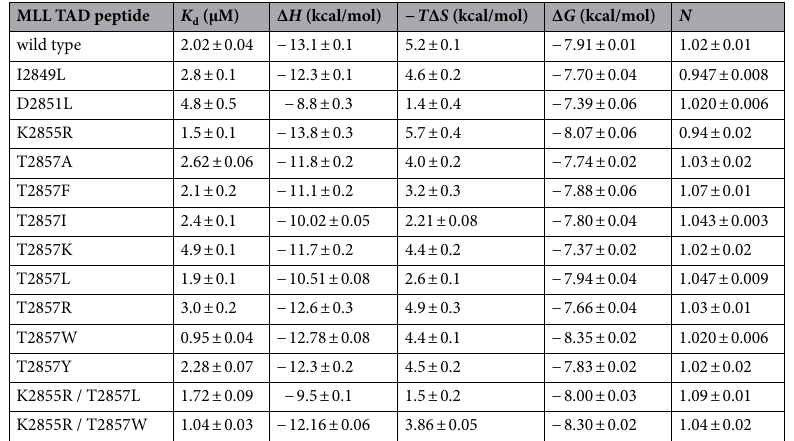
Table 1. Thermodynamic parameters for KIX binding of the designed peptides. The dissociation constant ( K d ), changes in enthalpy (Δ H ), entropy (Δ S ), and Gibbs free energy (Δ G ) upon binding, and stoichiometry of binding ( N ) were measured using isothermal titration calorimetry. The mean and standard error of triplicate or more measurements are shown. The K d values are plotted in Fig. 4d, and other parameters are plotted in Supplementary Fig.